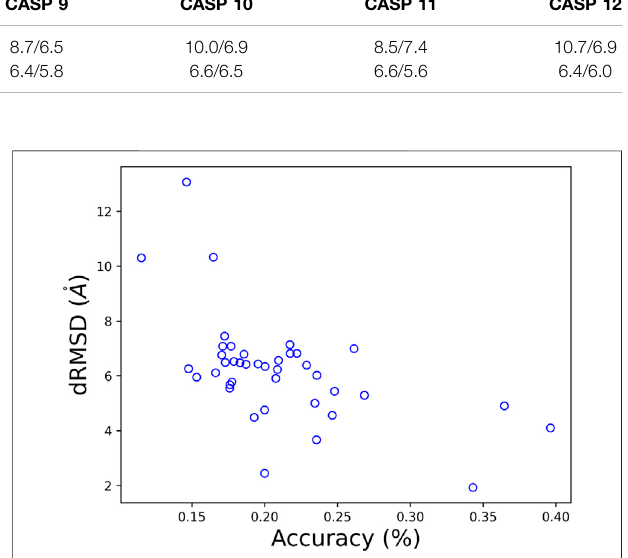
TABLE 2 | dRMSD (Å) comparison of recent Protein-Folding methods. Averages of FM (novel folds)/TBM (known folds) are shown. Model CASP 7